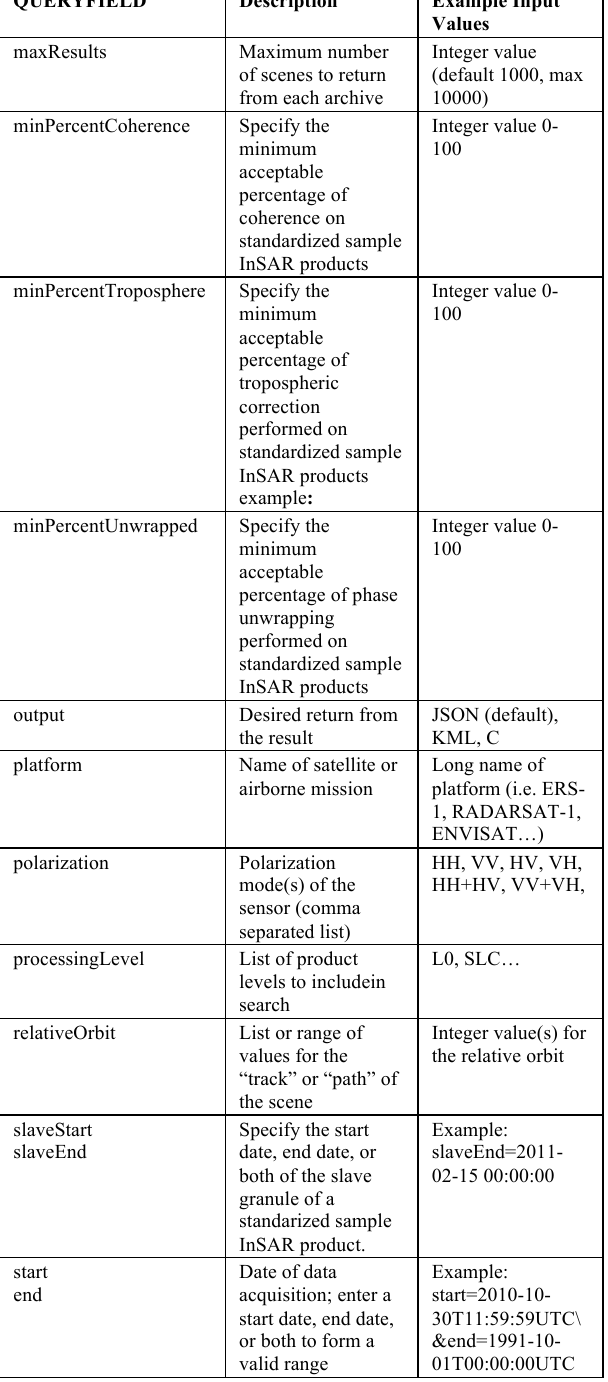
Table 12. SSARA API